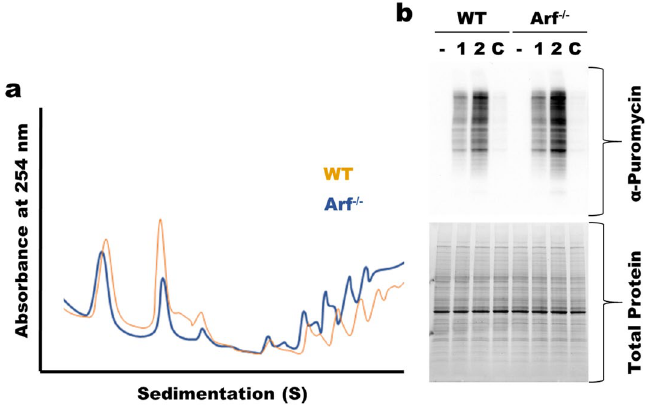
Figure 1. Upregulation of translation following loss of ARF. ( a ) Polysome profiling showing increased polysome peaks in Arf −/− MEFs ( b ) Puromycin translation assay showing increased protein production in Arf −/− MEFs. – untreated, 1 and 2 treatment with puromycin for 1 or 2 min, C indicates cells that were treated with cycloheximide prior to puromycin treatment for 2